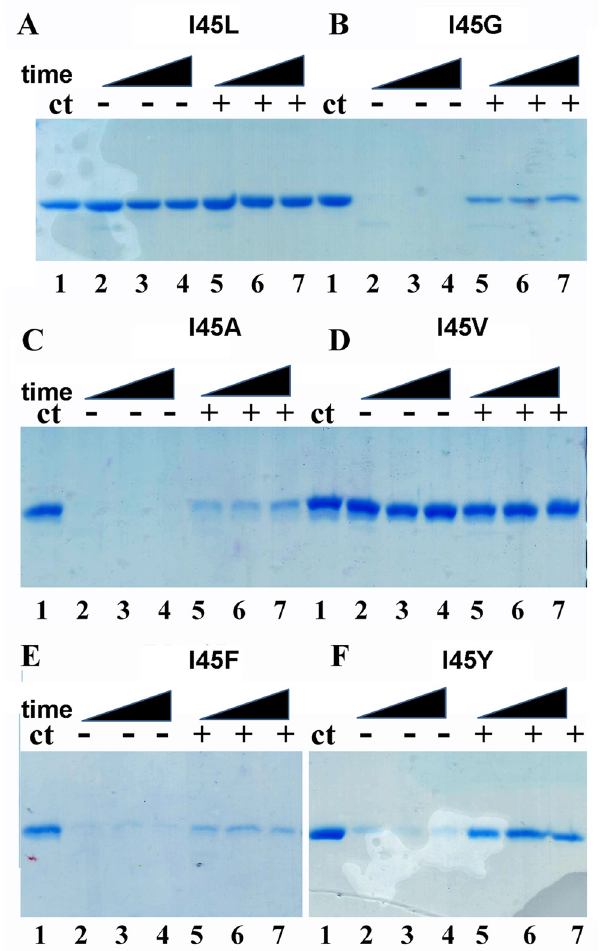
Fig 8. Monomeric TvTIMs are partially resistant to proteolysis upon 2PGA incubation. Time course experiment showing the partial proteolysis patterns of TvTIM mutants in the absence and in the presence of 2PGA. Dimeric TvTIMs are resistant to trypsinolysis with or without substrate analog (A and D). However monomeric TvTIMs are susceptible to trypinolysis in the absence of 2PGA but a small population of monomeric TvTIMs become resistant to after incubation with 2PGA (B,C,E,F). The extend of proteolysis is derived from the comparison to the control protein without added protease (lane